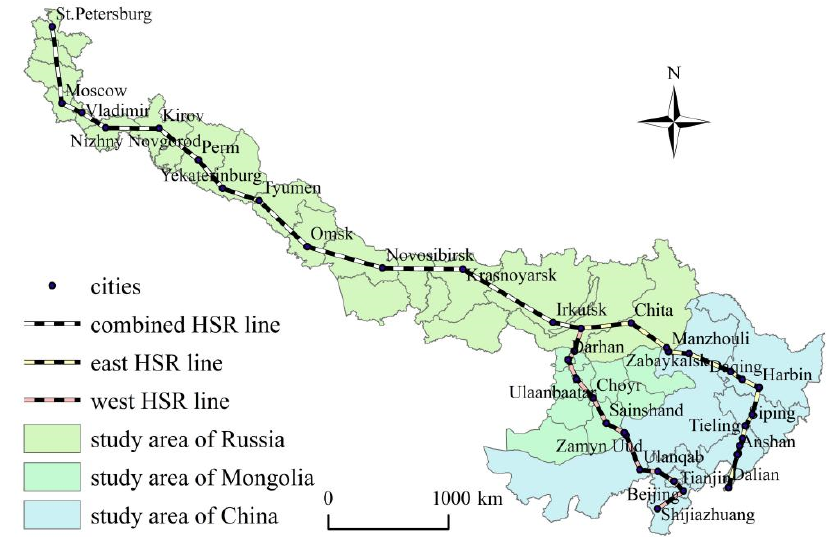
Figure 1. Sketch map of the study area.